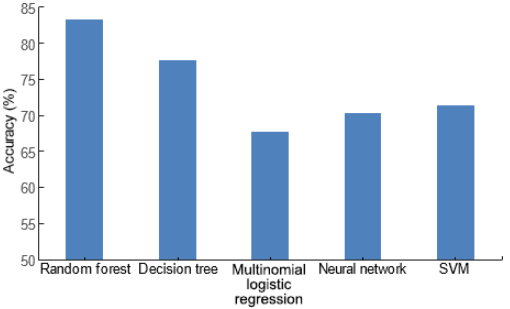
Fig. 4 Performance comparison of random forest model with other models in confirmed cases prediction.